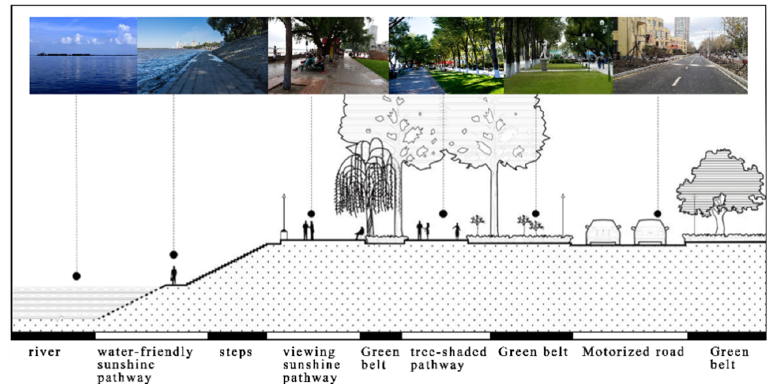
Figure 1. Location of Harbin in the Köppen–Geiger climate map of East Asia. Enhanced by the au-